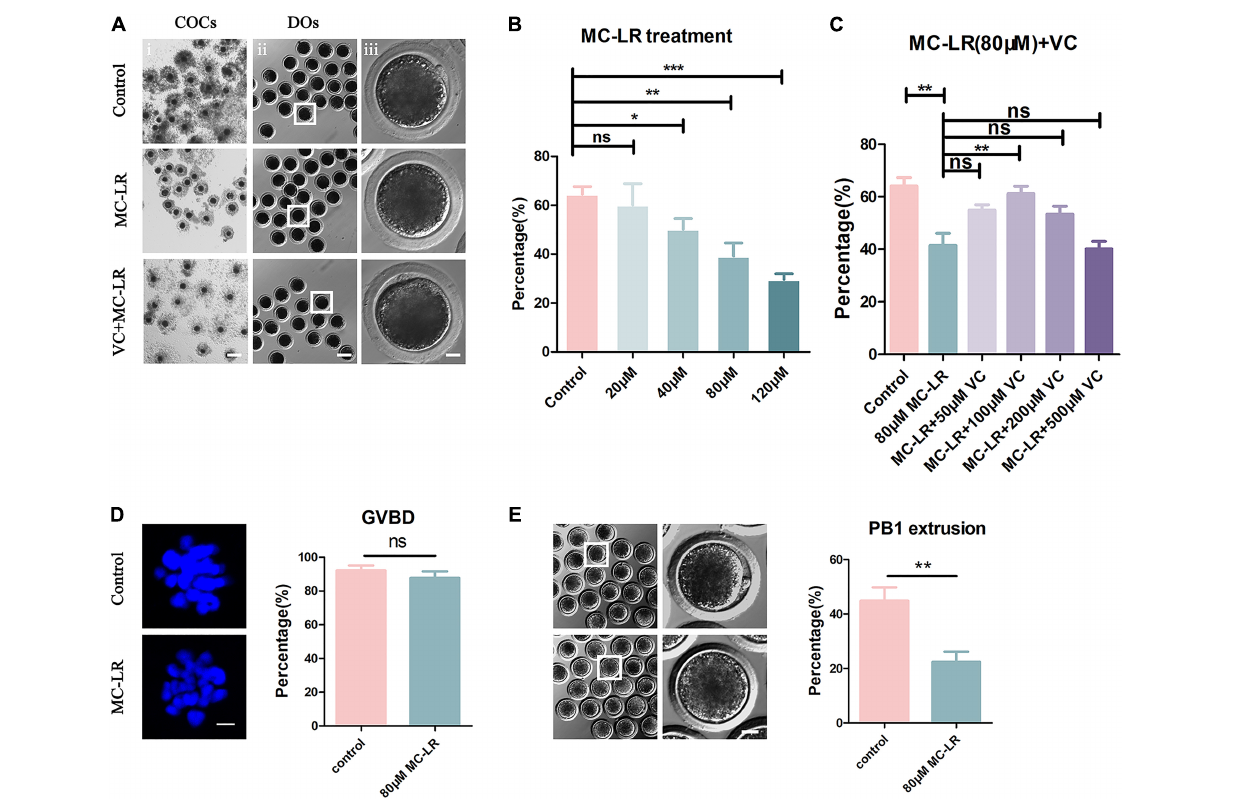
FIGURE 1 | VC (100 µ m) alleviates the meiotic defects in MC-LR-exposed oocytes. (A) Representative images of cumulus expansion and polar body extrusion (PBE) in the control, MC-LR-exposed, and VC-rescued groups (80 µ M MC-LR and 100 µ M VC were used). Bar = 150 µ m (i) ; 100 µ m (ii) ; 20 µ m (iii) . (B) The rate of PBE was compared in control and different concentrations of MC-LR-exposed groups (20 µ M, 40 µ M, 80 µ M, and 120 µ M) after being cultured for 44 h in vitro . (C) The rate of PBE was recorded in control and different concentrations of VC-supplemented groups (50 µ M, 100 µ M, 200 µ M, and 500 µ M) after culture for 44 h with 80 µ M MC-LR in vitro . (D) Representative images of chromosomes in porcine oocytes that underwent GVBD. And the rate of GVBD was recorded in control and MC-LR-exposed (80 µ M) oocytes. Bar = 2.5 µ m. (E) Representative images of PBE in the control and MC-LR-exposed (80 µ M) DOs. Bar = 20 µ m. * indicates significant difference at p < 0.05 level, ** indicates p < 0.01 level, *** indicates p < 0.001 level and ns indicates: no significant difference.